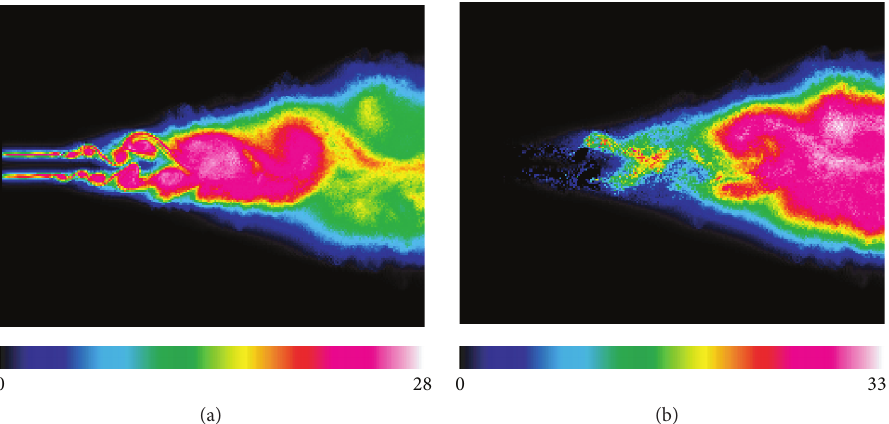
Figure 8: Instantaneous contours of the nanoparticle growth-rate decomposed by mechanism; 𝑧 -direction averaged particle growth-rate (a) by condensation, (b) by